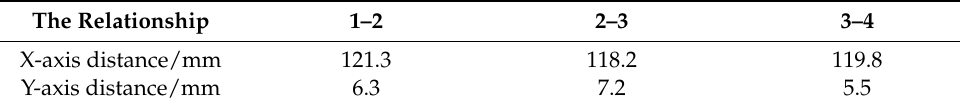
Table 1. Actual distance of modular vehicles with “—” shape.